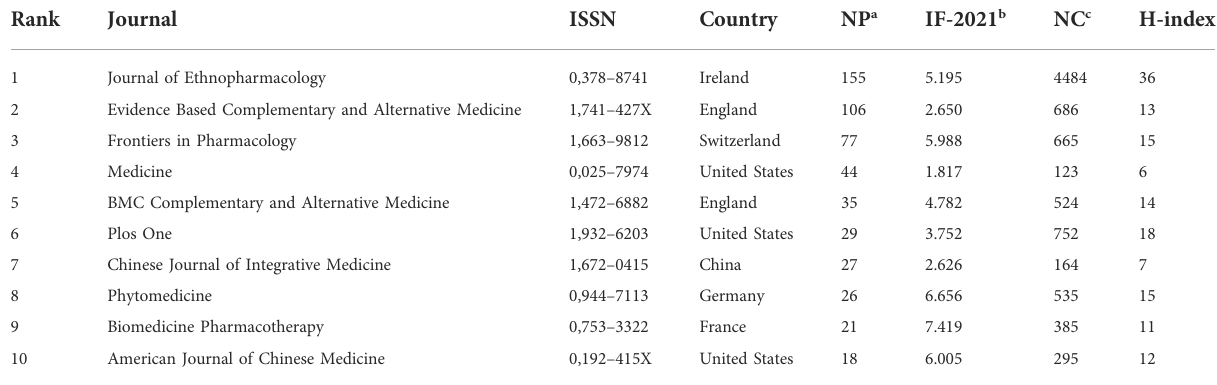
TABLE 4 The top 10 most productive journals in the fi eld of herbal medicine to control